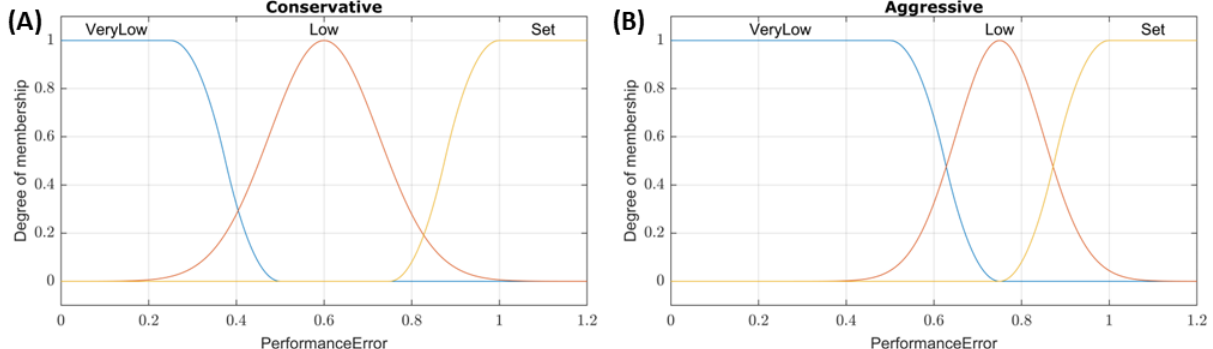
Figure 1. Membership function plots for SFL controllers. Plots of the PerformanceError input mem- bership functions for ( A ) conservative and ( B ) aggressive tuned single-input fuzzy logic control-